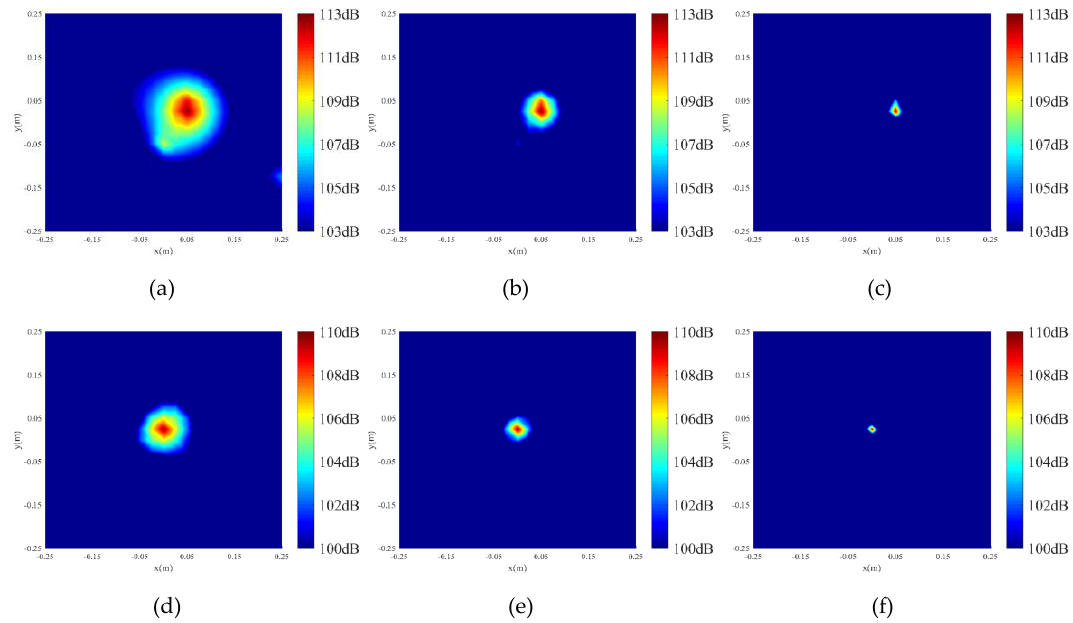
Figure 11. Pressure distributions under experimental conditions of (a) ERDCESM with 𝜈 = 0 at 500 Hz, (b) ERDCESM with 𝜈 = 1 at 500 Hz, (c) ERDCESM with 𝜈 = 3 at 500 Hz, (d) ERDCESM with 𝜈 = 0 at 2000 Hz, (e) ERDCESM with 𝜈 = 1 at 2000 Hz and (f) ERDCESM with 𝜈 = 3 at 2000 Hz for a single source.